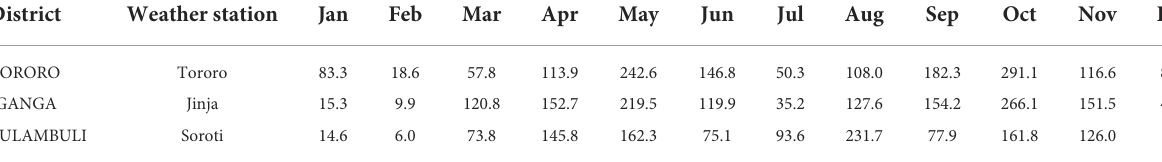
TABLE A1 Monthly rainfall totals (in mm) of 2014 for the study districts from the proximate weather station. District